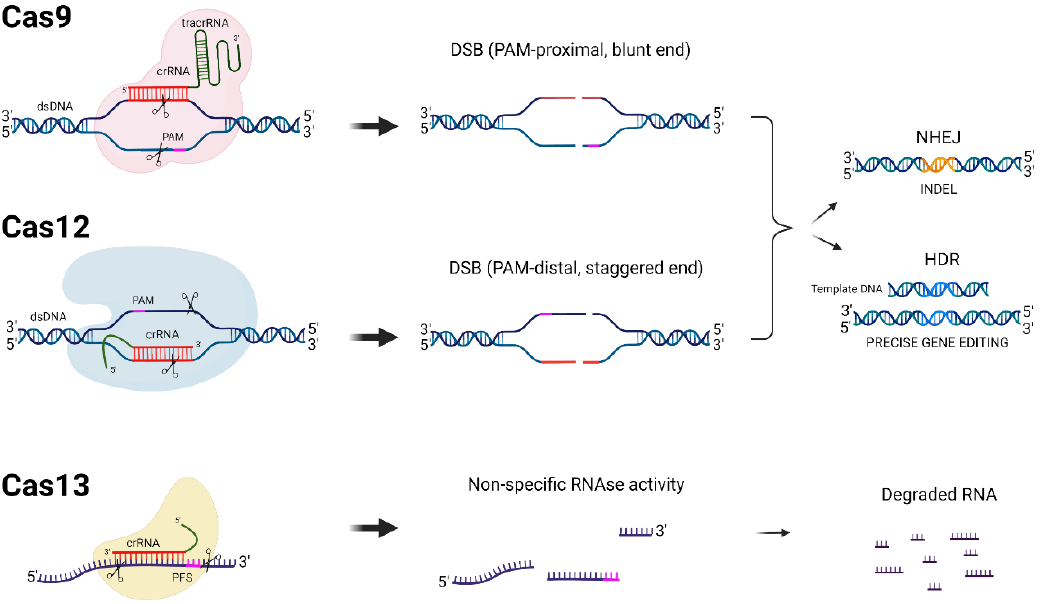
Figure 1. DNA- and RNA-targeting CRISPR-Cas systems. Different CRISPR-Cas proteins (Cas9, Cas12, and Cas13), their target molecules, and the cleavage mechanisms that they employ are schematically depicted. The protospacer adjacent motif (PAM) required for Cas9 and Cas12 cleavage in addition to the protospacer flanking site (PFS) required for some Cas13 orthologues are shown in pink. The crRNAs are depicted in red for each CRISPR-Cas system. When double-strand DNA breaks (DSBs) are created by Cas9 and Cas12, cellular DNA repair mechanisms are induced, either non-homologous end joining (NHEJ) or homology-directed repair (HDR). HDR requires a donor DNA template and can result in precise gene editing, while NHEJ is an error-prone repair process that introduces mutations, insertions, and deletions (INDELS, shown in orange). The Cas13 recognition and cleavage of a target RNA transcript leads to its degradation and possibly the non-specific degradation of nearby transcripts (collateral RNA cleavage).